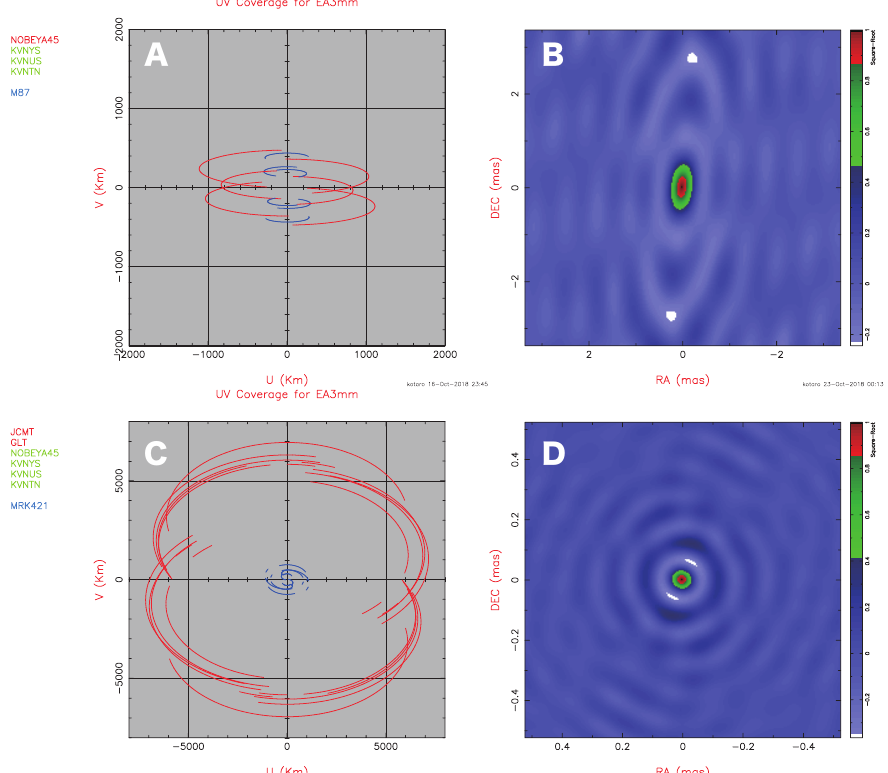
Figure 11. ( A ): The uv -coverage for M87 (declination δ of ∼ 12 ◦ ) expected by the observation with 8-hr tracks using the NRO45 and KVN baselines. The solid red line indicates the NRO45 baselines. ( B ): The synthesized beam expected to be achieved by the NRO45 and KVN baselines for M87. ( C ): The uv -coverage for Mrk 421 (declination δ of ∼ 38 ◦ ) expected by the observation with 8-hr tracks using the NRO45, KVN, GLT, and JCMT baselines. The solid red line indicates the GLT and JCMT-related baselines. ( D ): The synthesized beam expected to be achieved by the NRO45, KVN, GLT, and JCMT baselines for Mrk